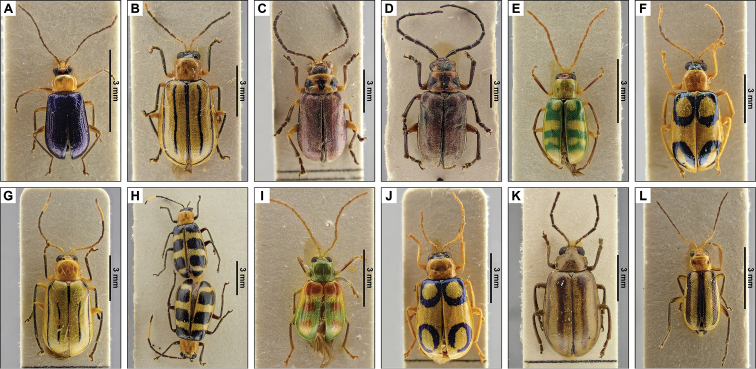
Dorsal pictures of the species of Galerucinae excluding Alticini from El Salvador currently present in the collections of the RBINS. AAcalymmasemicaeruleaBAmphelasmanigrolineatumCCoraiaclarkiDC.maculicollisEDiabroticabalteataFD.circulataGD.curvilineataHD.pulchraID.viridulaJNeobroticaornataKPyesiadetritalaevicollis. High resolution images can be found at http://collections.naturalsciences.be/ssh-entomology.